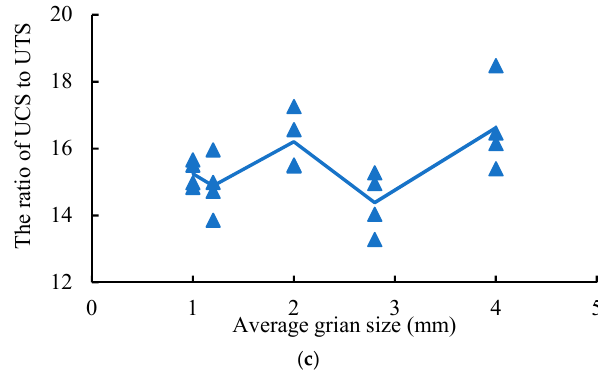
Figure 12. UCS, UTS, and the ratio of UCS to UTS varying with average grain size, respectively. ( a ) UCS varying with average grain size; ( b ) The UTS varying with average grain size; ( c ) The ratio of UCS to UTS varying with average grain size.